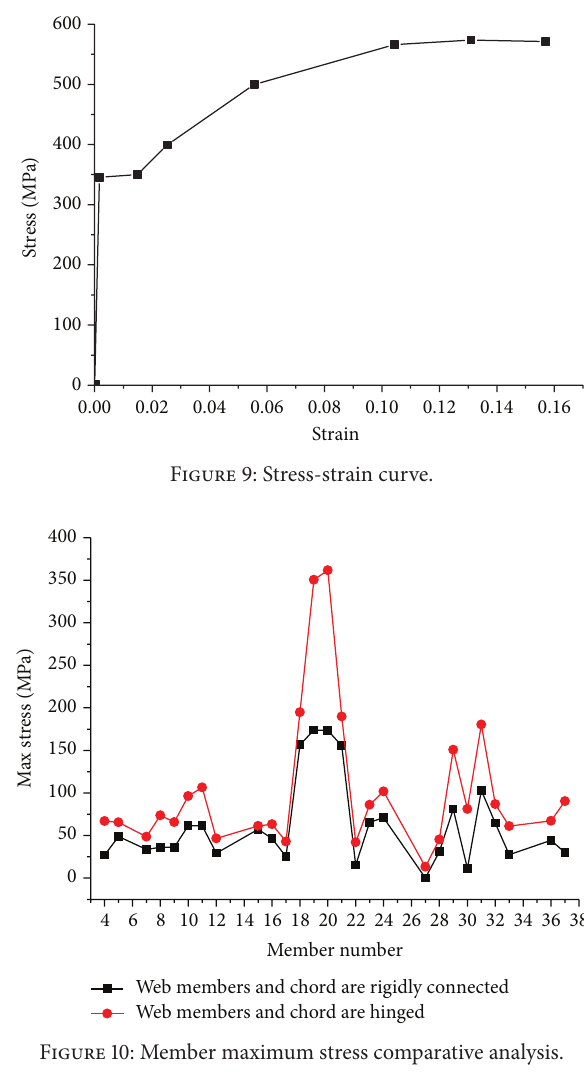
Figure 10: Member maximum stress comparative